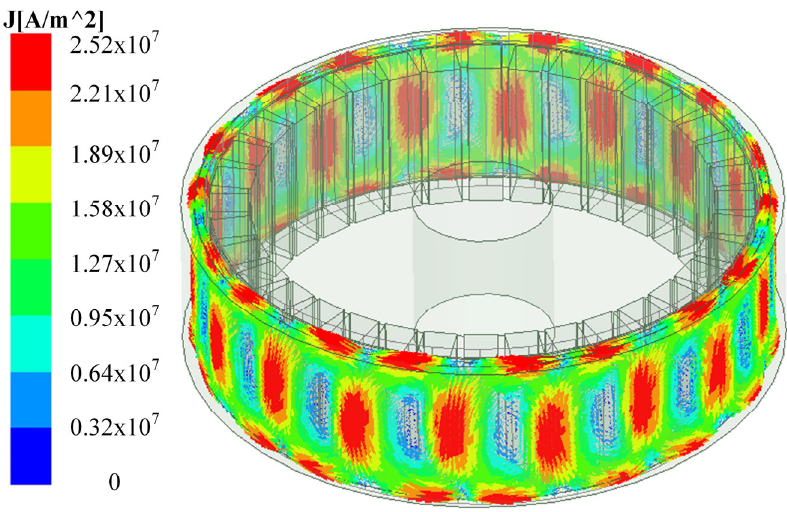
Figure 11. Eddy current distribution across copper rings.